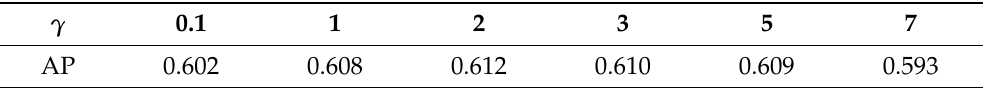
Table 3. The AP values of the results were obtained by comparing different γ values on the UCAS- AOD dataset. (AP is the average of 10 values of AP taken between IoU = 50 and IoU = 95). γ 0.1